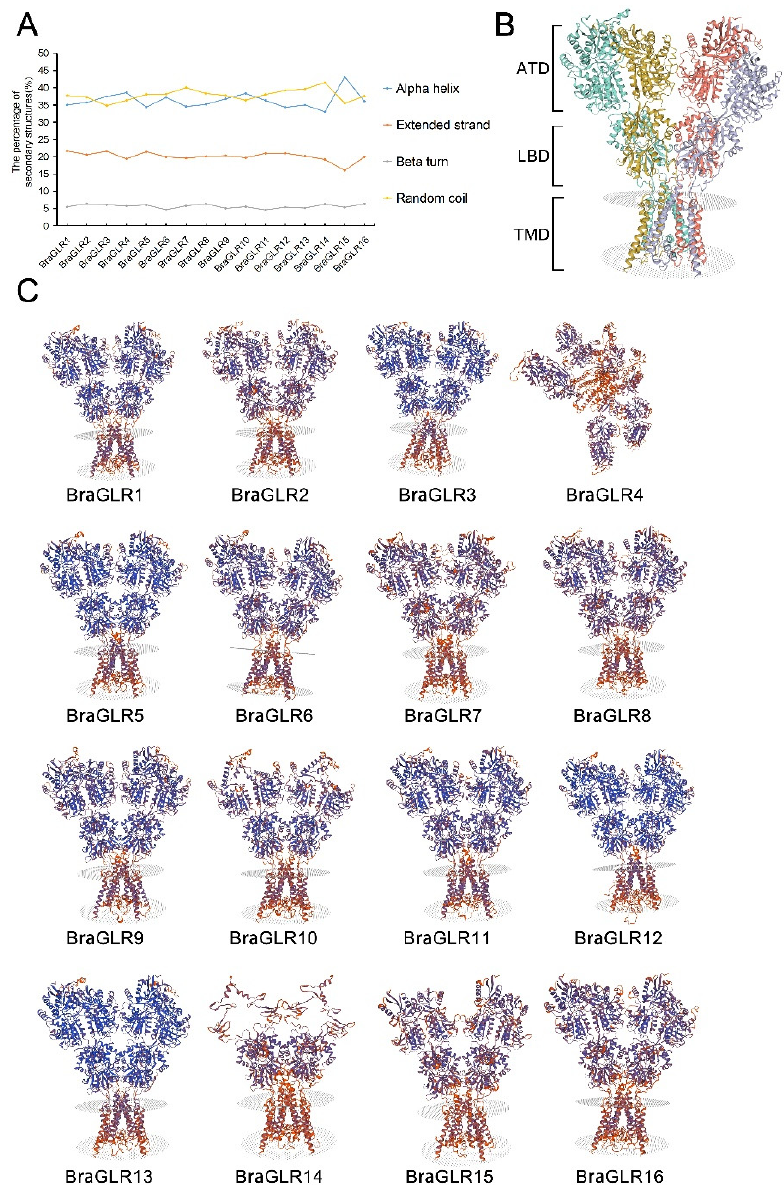
Figure 8. Analysis of BraGLRs’ protein secondary structure and tertiary structure. ( A ) Prediction of secondary structure of GLR proteins in B. rapa . ( B ) Predicted tertiary structure of BraGLR1 protein. Four subunits are shown in different colors. The structure of BraGLR1 has a three-layer architecture, which includes the amino-terminal domain (ATD) layer, the ligand-binding domains (LBD) layer, and the transmembrane domain (TMD) layer. ( C ) Prediction of tertiary structure of GLR proteins in B. rapa .